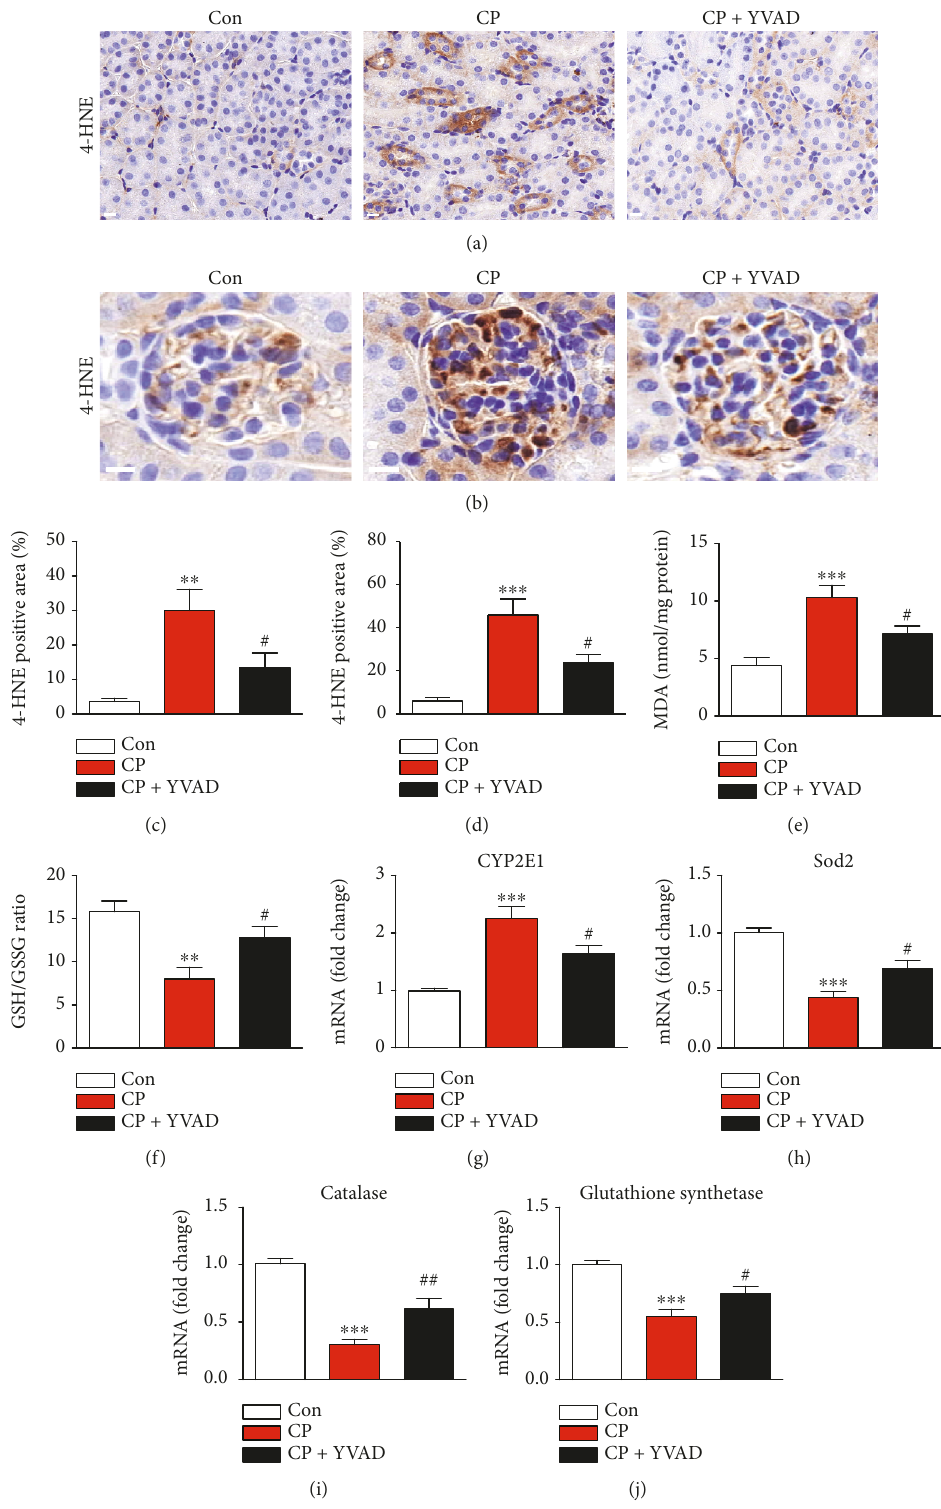
Figure 4: E ff ects of Ac-YVAD-cmk on cisplatin-induced oxidative damage in the kidneys. Representative images of immunohistochemical staining using anti-4-HNE antibody in the cortex (a) and glomerulus (b). Scale bar: 25 μ m. Graphs show the percentage of 4-HNE-stained area per fi eld in the cortex (c) and glomerulus (d). (e) Level of malondialdehyde (MDA). (f) GSH/GSSG ratio. Real-time RT-PCR analysis of CYP2E1 (g), SOD2 (h), catalase (i), and glutathione synthetase (j) in the kidneys. Con: control, CP: cisplatin, and CP +YVAD: cisplatin plus Ac-YVAD-cmk. n = 8 per group. All data are expressed as the mean ± SEM. ∗∗ P < 0 01 and ∗∗∗ P < 0 001 vs. Con. # P < 0 05 and ## P < 0 01 vs.